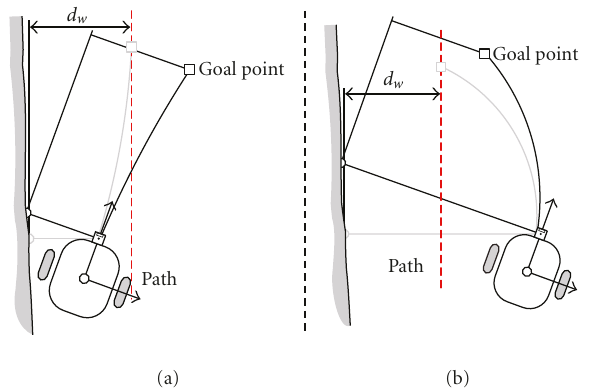
Figure 5: False minimum range with a 180 ◦ partial field of view laser scanner with left wall following, when the robot distance is (a) smaller than d w , or (b) greater than d w